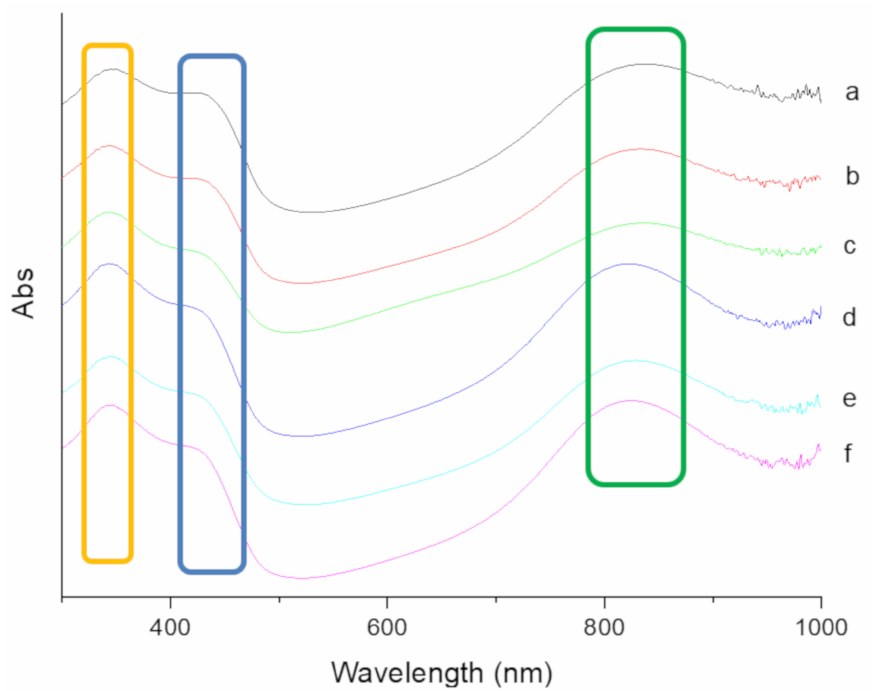
Figure 4. UV-Vis spectra of ( a ) pure PANDB and conductive PANDB/ γ -Al 2 O 3 core–shell nanocom- posites synthesized at the weight ratios of AN/ γ -Al 2 O 3 = ( b ) 3/1, ( c ) 3/2, ( d ) 3/3, ( e ) 3/4, and ( f )